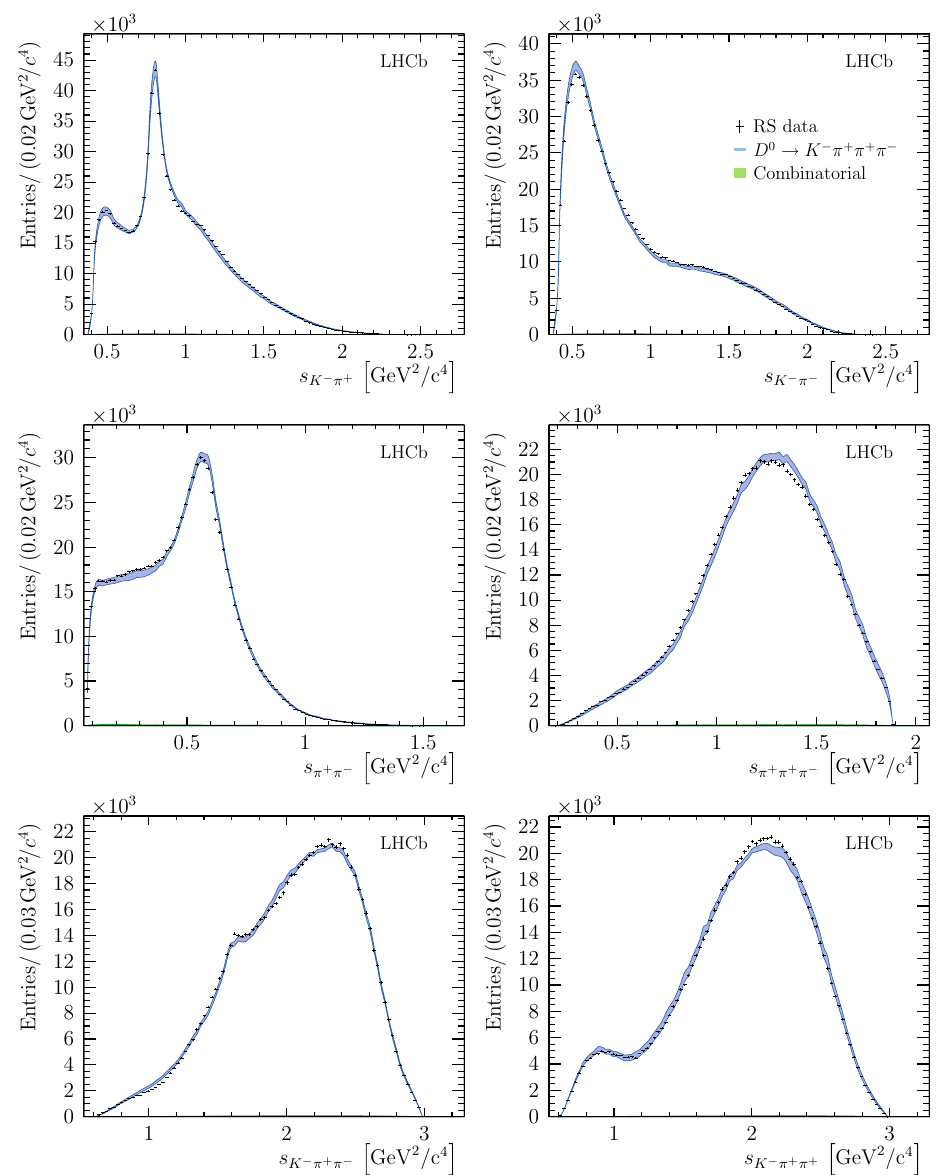
width of the band indicating the total systematic uncertainty. The total background contribution, which is very low, is shown in